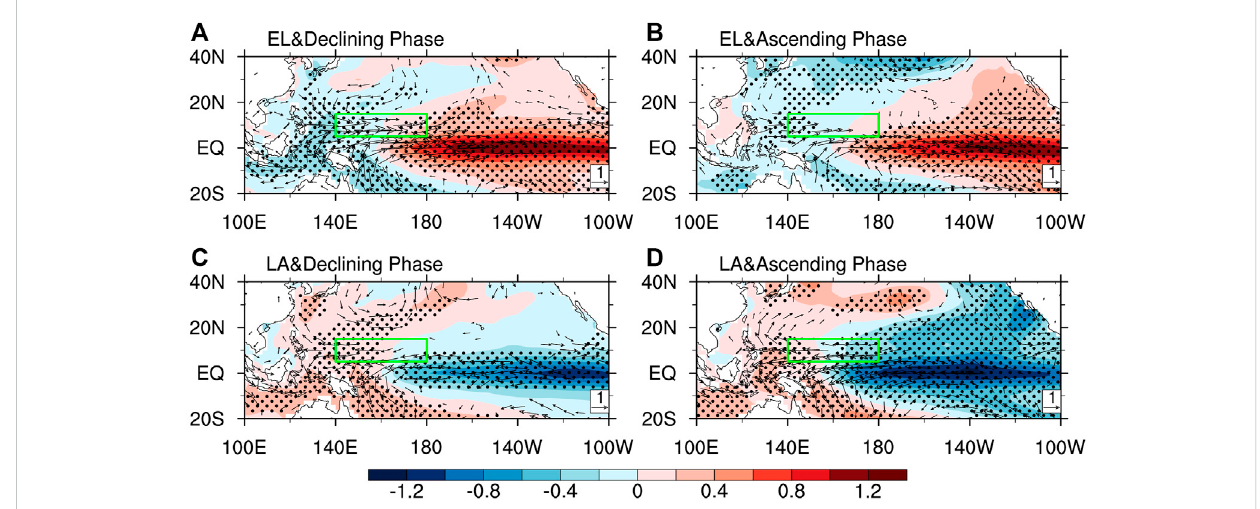
FIGURE 5 Composite SST anomalies (shaded; units: ° C) and wind anomalies at 925 hPa (vector; units: m s − 1 ) in JJASON in (A) , (B) El Niño and (C) , (D) La Niña years during different solar cycle phases. Dots (vectors) indicate SST (wind) anomalies are signi fi cant at the 99% con fi dence level.